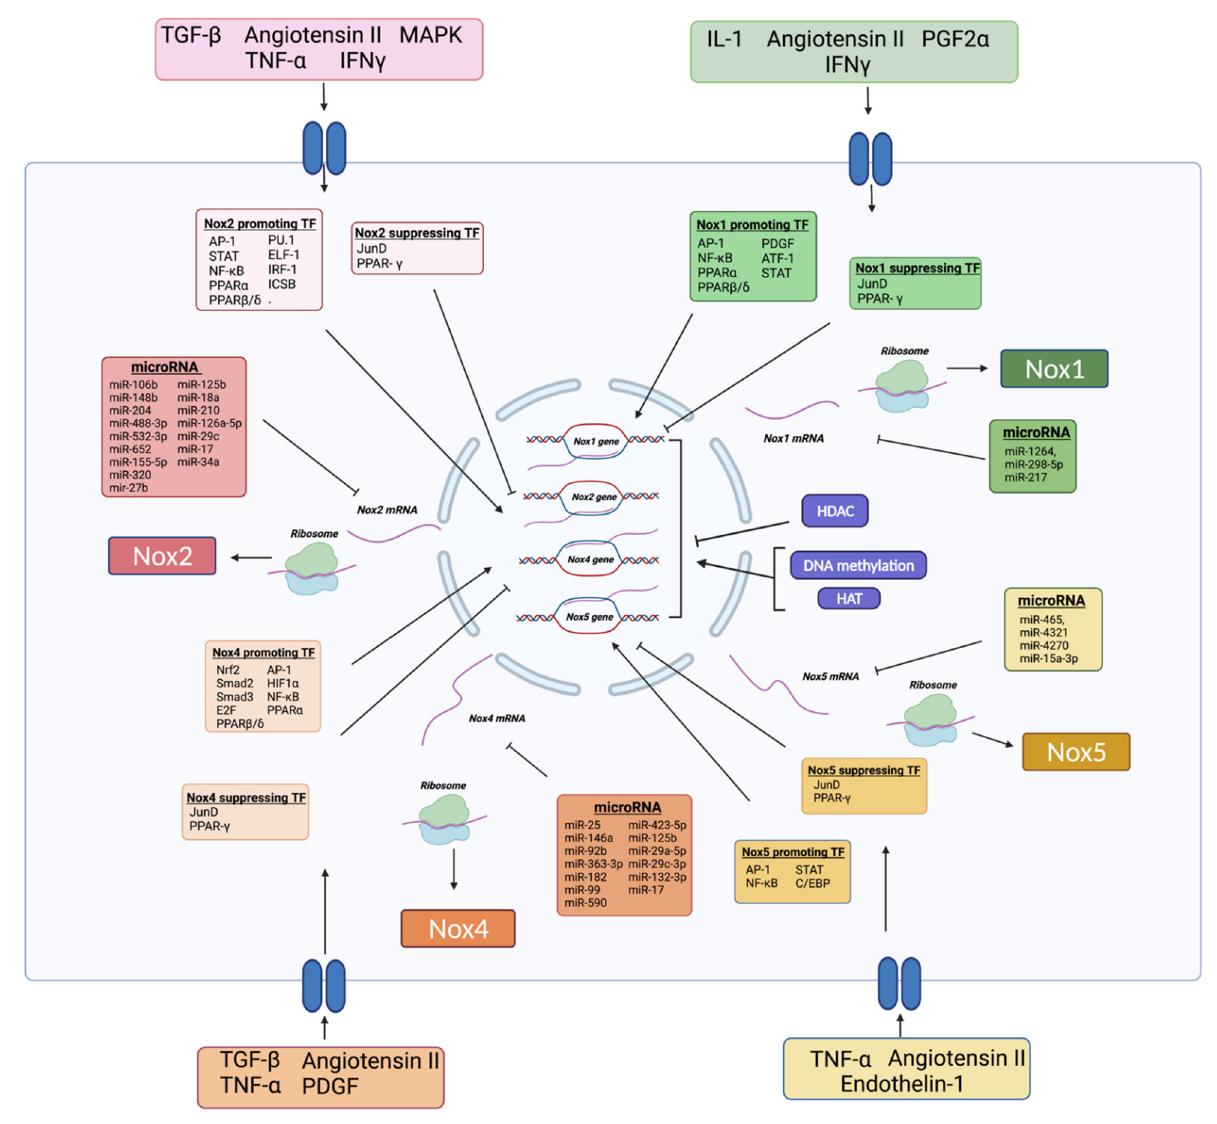
Figure 2. Transcriptional and epigenetic regulation of Nox. A variety of protein kinases, hormones and cytokines act to modulate transcription of Nox through Nox promoting and suppressing transcription factors. Epigenetic mechanisms play a major role regulating Nox. Within the nucleus, HDACs de-acetylate histone proteins, reducing chromatin relaxation and suppressing Nox transcription. In addition, histone acetylation (HAT) and DNA methylation increase Nox activity. Following gene transcription, Nox mRNA is degraded by a wide variety of miRs before being translated into Nox protein within ribosomes. Abbreviations: activator protein 1 (AP-1), activating transcription factor-1 (ATF-1), CCAAT/enhancer- binding proteins (C/EBP), E74-like factor 1 (ELF-1), histone deacetylation (HDAC), hypoxia-inducible factor 1 alpha (HIF1 α ), interferon consensus sequence binding protein (ICSB), interferon gamma (IFN- γ ) Interferon regulatory factor-1 (IRF-1) messenger RNA (mRNA), microRNA (miR), mitogen-activated protein kinase (MAPK), Nox1 isoform of NADPH oxidase (Nox1), Nox2 isoform of NADPH oxidase (Nox2), Nox4 isoform of NADPH oxidase (Nox4), Nox5 isoform of NADPH oxidase (Nox5), nuclear factor kappa-light-chain-enhancer of activated B cells (NF- κ B), peroxisome proliferator-activated receptor (PPAR), platelet derived growth factor (PDGF), prostaglandin F2 α (PGF2 α ), signal transducer and activator of transcription protein (STAT), transforming growth factor- β (TGF- β ), transcription factor (TF), tumour necrosis factor α (TNF- α ). Created with BioRender.com (accessed on 31 August 2021). The promotor region of the Nox5 gene has binding sites for multiple transcription factors including: AP-1, NF- κ B, STAT and C/EBP [56,62]. In addition, expression of Nox5 mRNA is significantly increased by angiotensin II, endothelin-1 and TNF- α